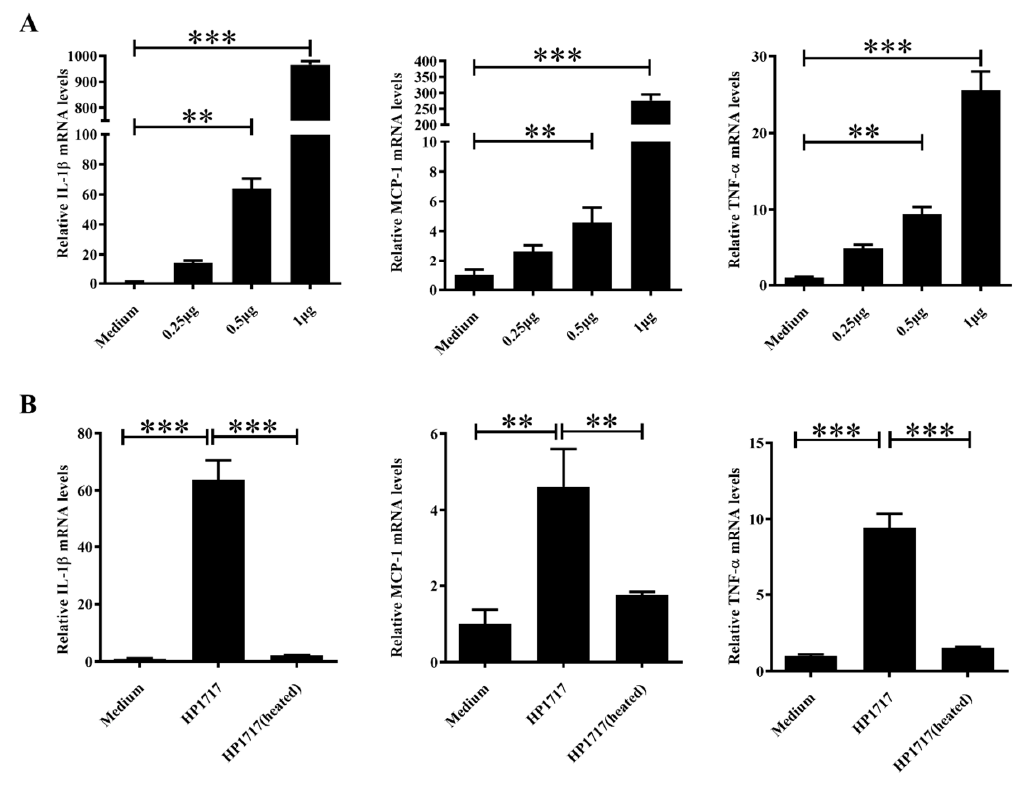
Figure 3. Experiments to determine the proinflammatory properties of HP1717. ( A ) The dose-dependent experiments were followed by qRT-PCR to measure transcript levels. ( B ) In the heat